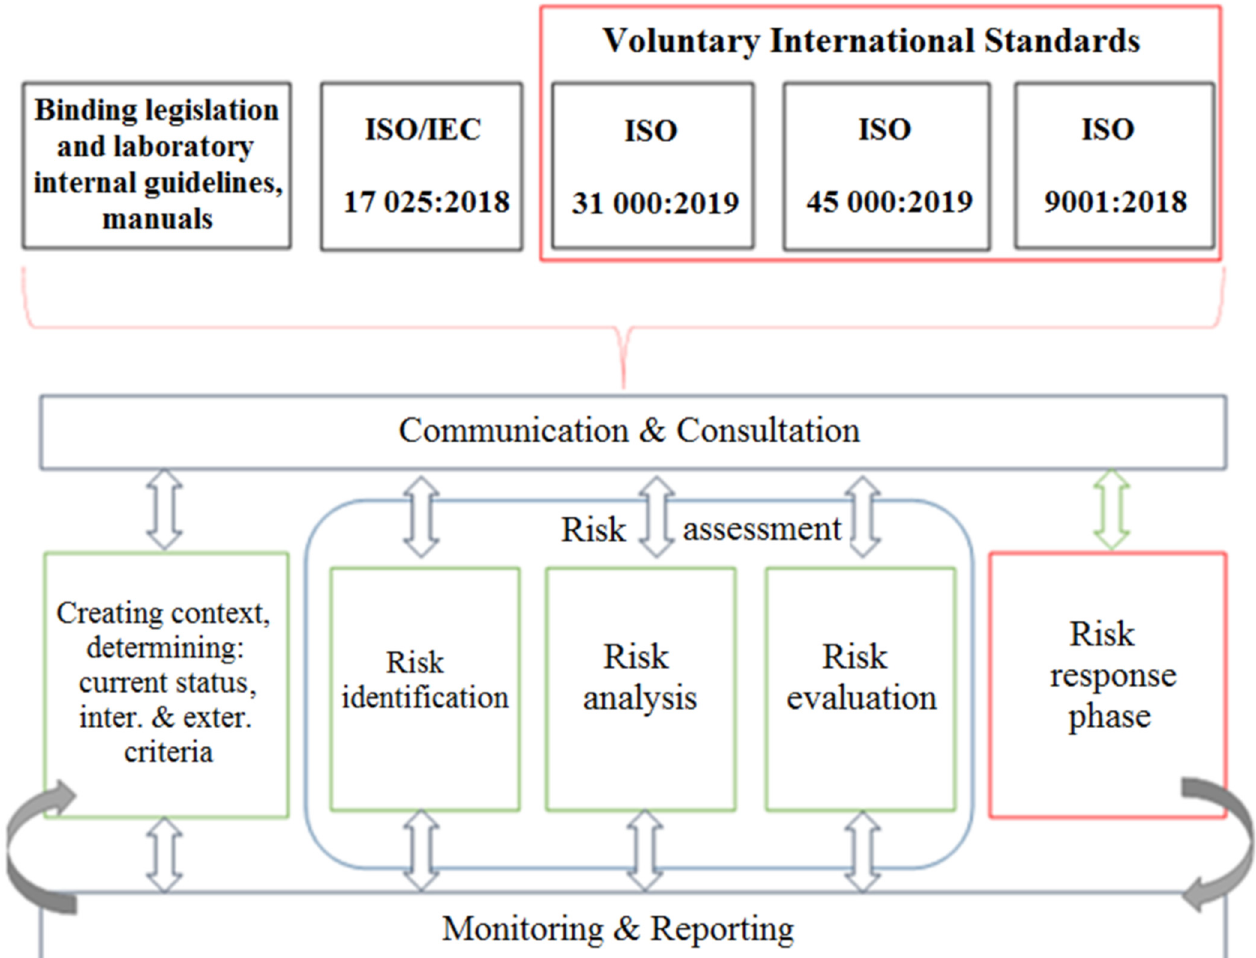
Figure 1. Methodology of risk management.